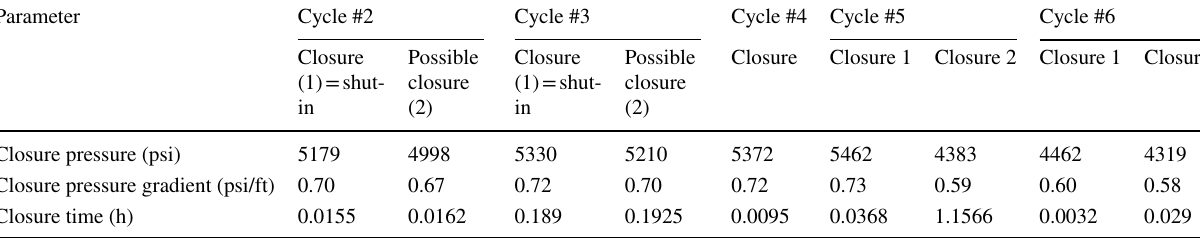
Table 3 Estimated closure pressure and time for Injection Cycles #2 through #6